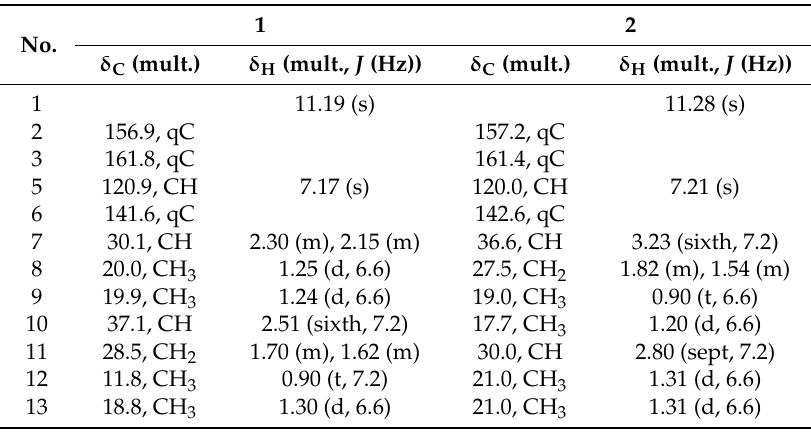
Table 1. NMR data of compounds 1 and 2 (600 and 150 MHz, CDCl 3